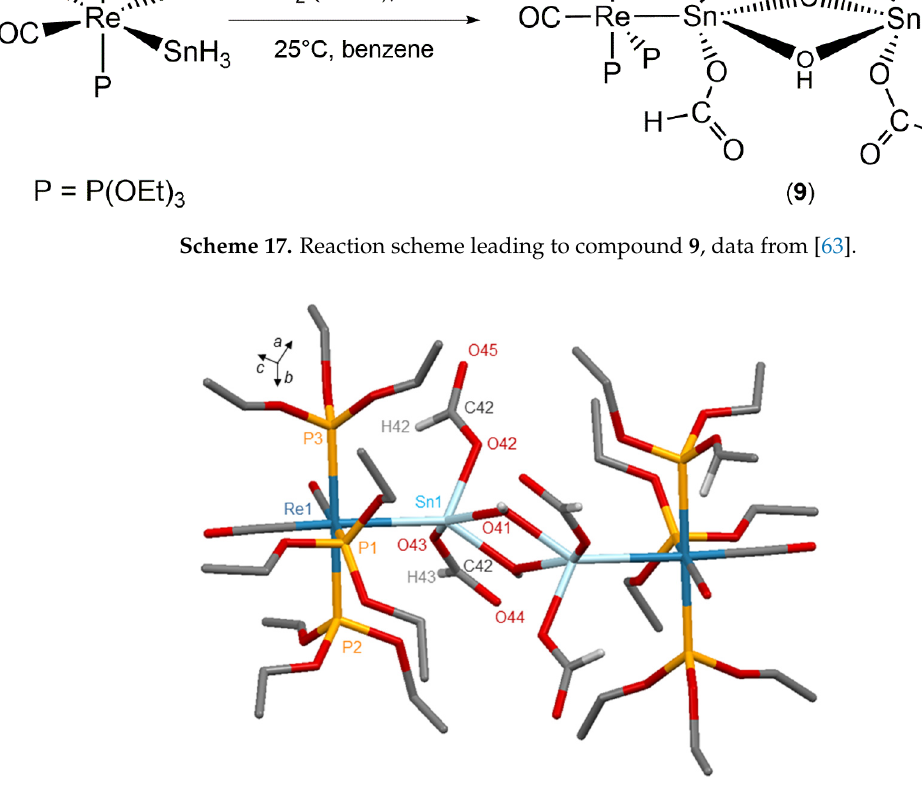
Figure 12. Molecular structure of 9 , adapted from [63] (MERCURY view). Hydrogen atoms are omitted for clarity except those of hydroxyl and formate groups (Re blue, Sn light blue, O red, P orange, C grey, H white).